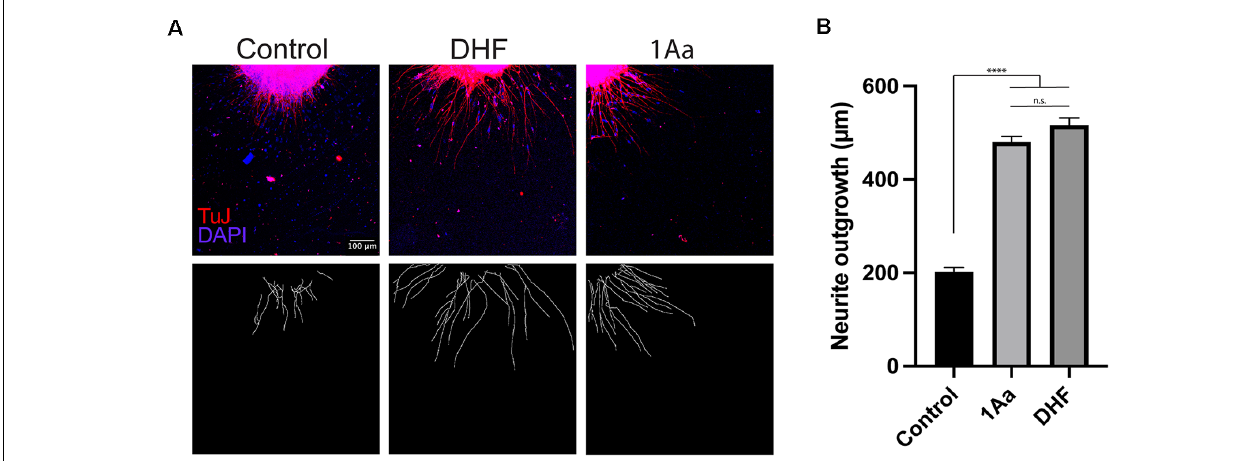
FIGURE 3 | 1Aa promotes neurite outgrowth in vitro . (A) SGN neurite outgrowth in vitro . Neurites were stained with neuronal marker TuJ (red), and nuclei were labeled with DAPI (blue). Scale bar represents 100 µ m. Images are representative of four independent experiments. (B) Quantification of neurite outgrowth in µ m compared to DMSO control and DHF (n.s., not significant; ∗∗∗∗ represents p ≤